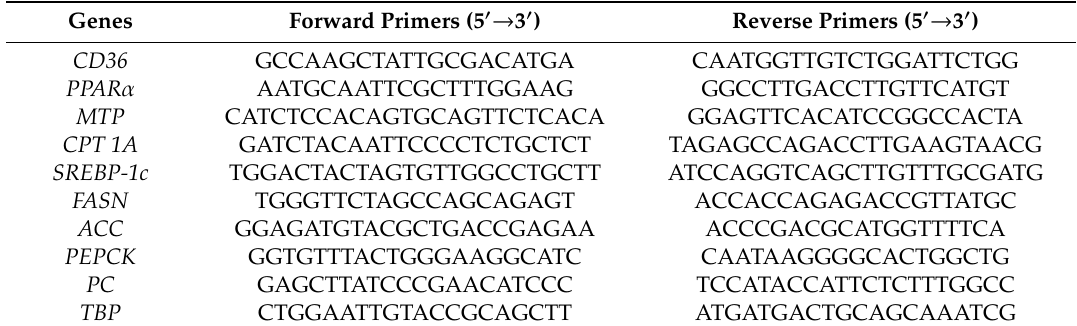
Table 1. Primers used in additional real-time